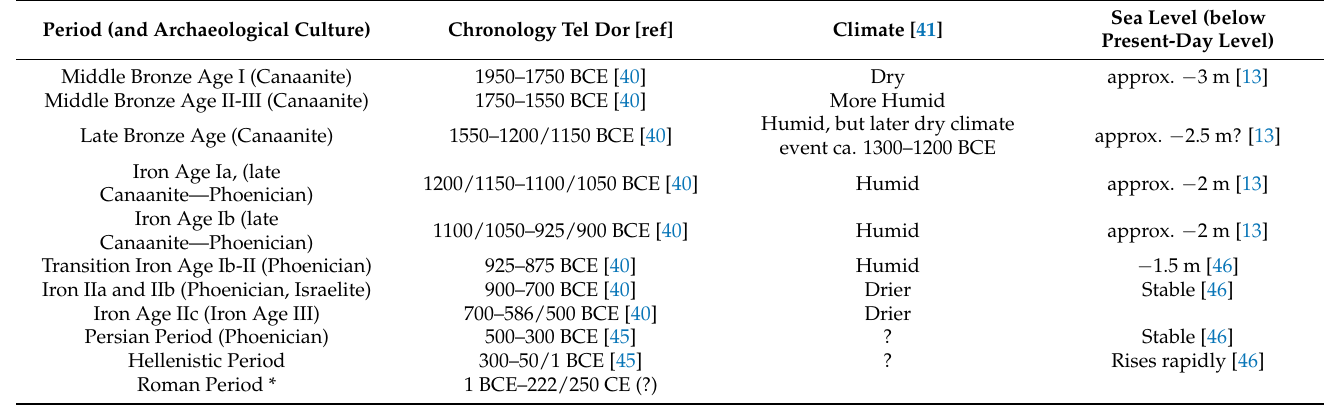
Table 1. Chronology [40,45], climate [44], and sea level [13] at Tel Dor. Forward slashes indicate the range of dates provided. * The South Bay of Dor fell into disuse as a port after the Roman period. There is evidence for scarce settlement on the Tel afterwards, but the port shifted to the North Bay [31]. BCE—Before the Common